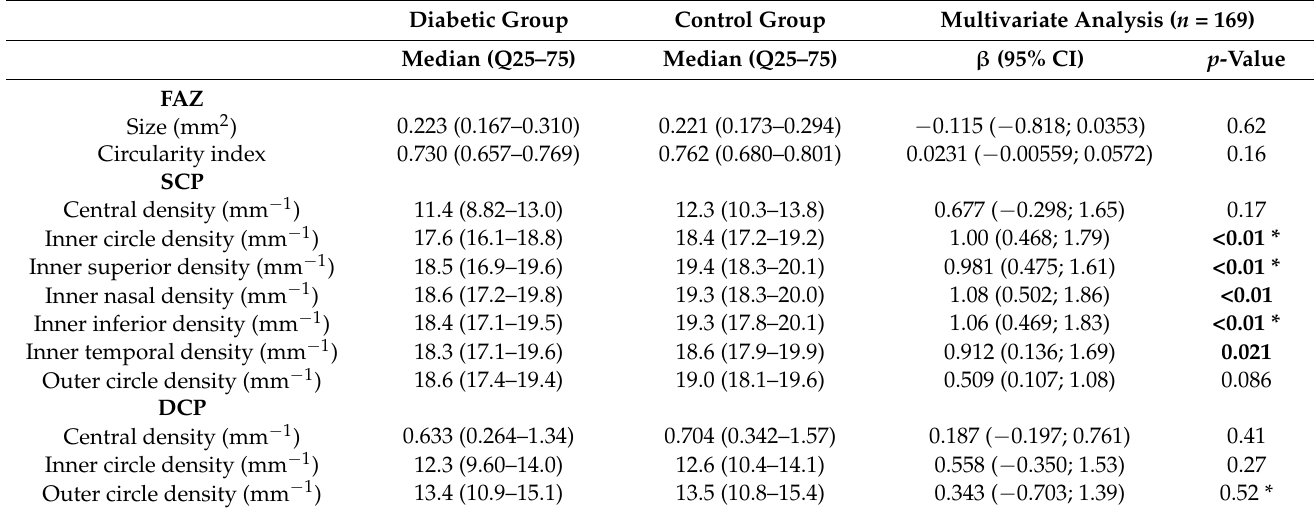
Table 2. Comparison of retinal microvascularization between diabetes and control groups.